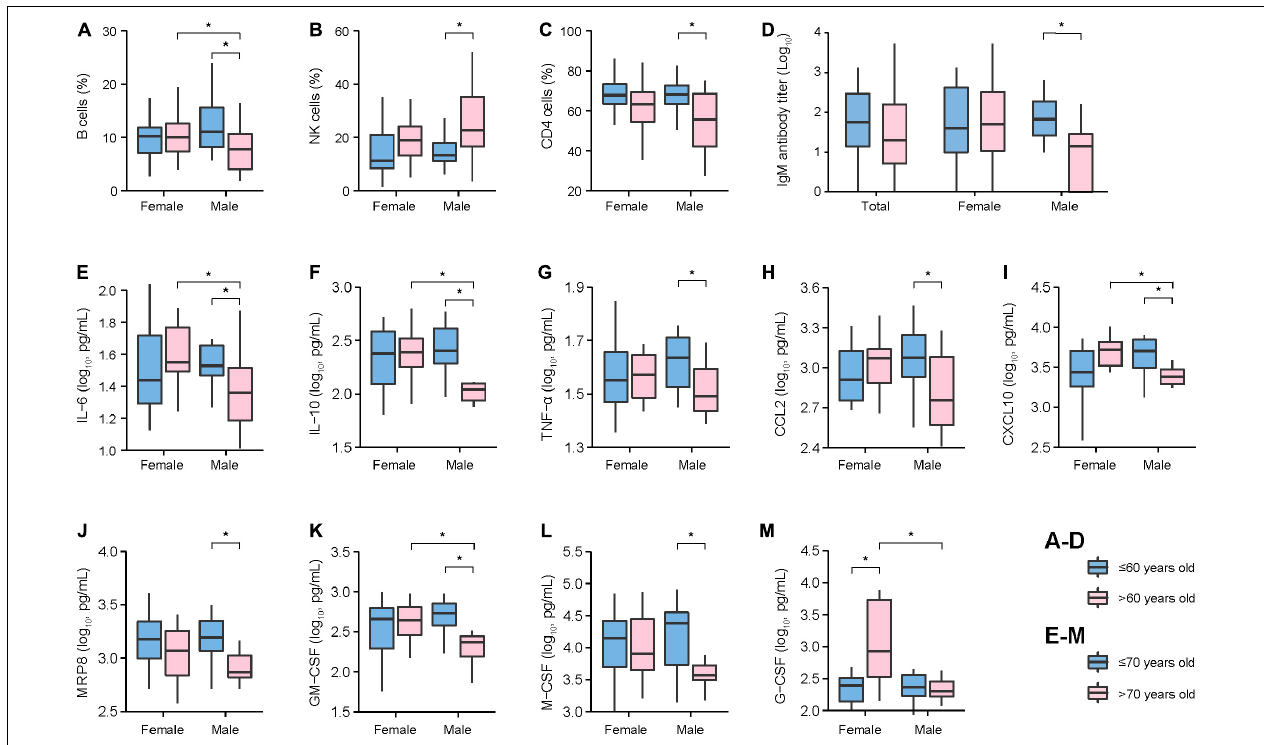
FIGURE 3 | Comparison of cellular immunity (A–C) , humoral immunity (D) , cytokines, and chemokines (E–M) between age groups stratified by sex. P values were calculated by Wilcoxon rank sum tests. The age groups were classified by median values. For panels (A–D) , two age groups were divided by 60 years. For panels (E–M) , two age groups were divided by 70 years. For each evaluation, the median value and the 25th to 75th quantiles were shown. Asterisk (*) means statistical significance of P < 0.05 between two age